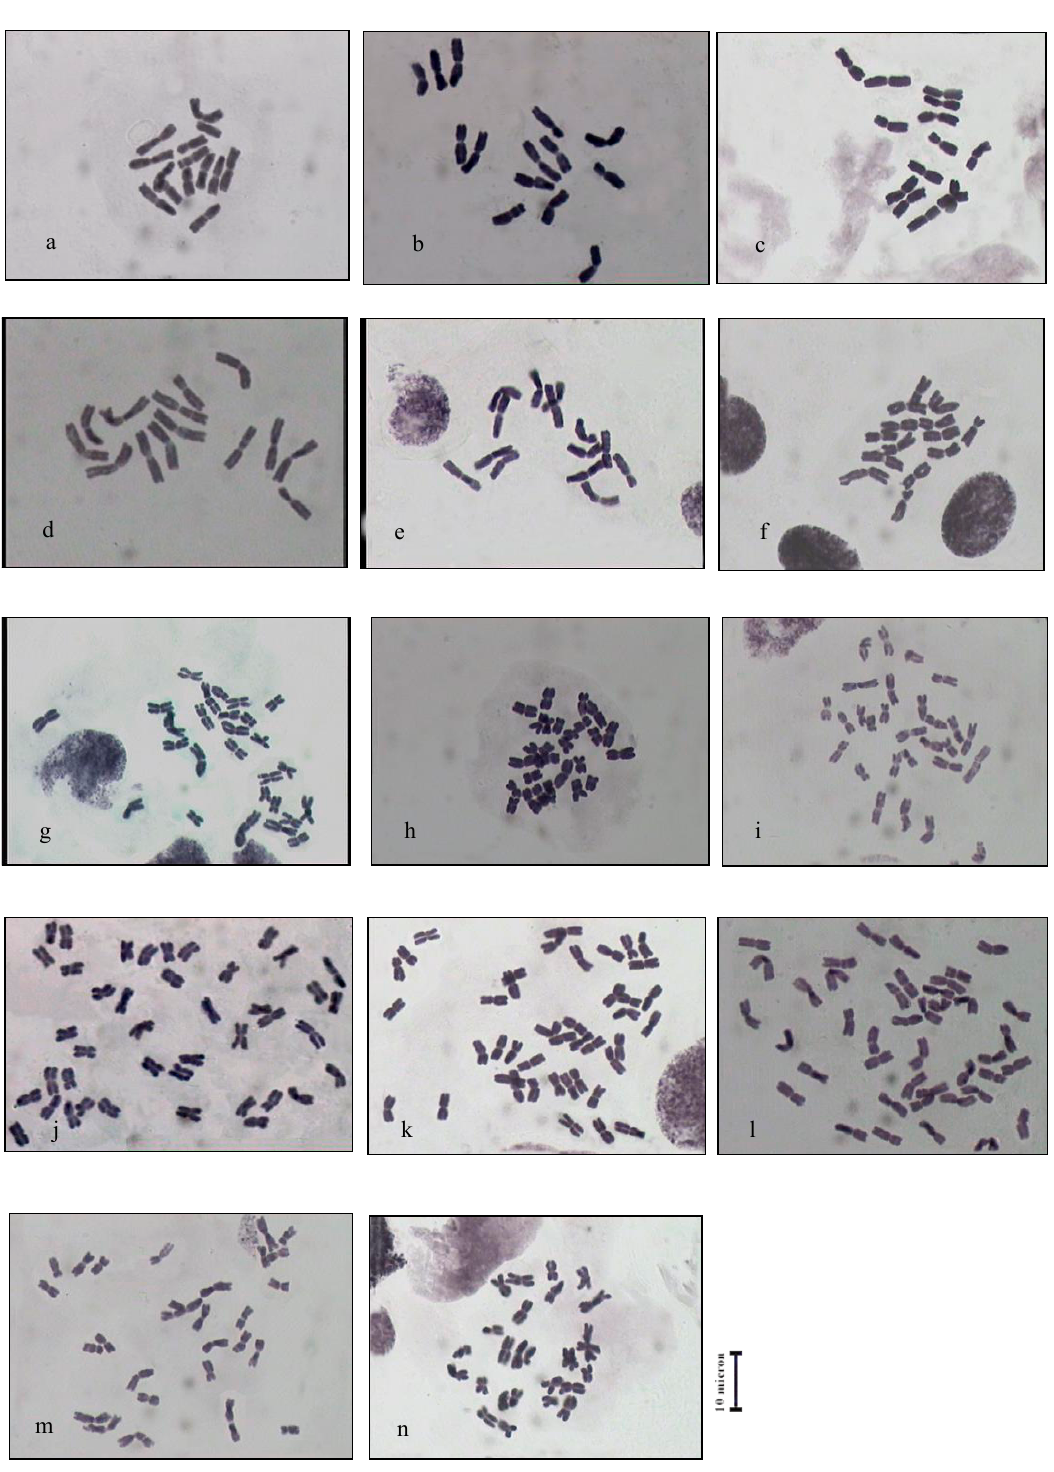
Figure 1. Representative mitotic plates of Bromus – (a) B. scoparius (5983), 2n=2x=14, (b) B. scoparius (5984), 2n=2x=14, (c) B. scopari- us (5985) 2n=2x=14, (d) B. japonicus (16462), 2n=2x=14, (e) B. japonicus (16525), 2n=2x=14, (f) B. japonicus (16587), 2n=2x=14, (g) B. rubens (15169), 2n-4x=28, (h ) b. rubens (15317), 2n=4x=28, (i) B. rubens (2125), 2n=4x=28, (j) B. tomentellus (Bavanat), 2n=6x=42, (k) B. tomentellus (Simakan), 2n=6x=42, (l) B. tomentellus (Eghlid), 2n=6x=42, (m) B. madritensis (3668). 2n=4x=28, (n) B. madritensis (Arjan),